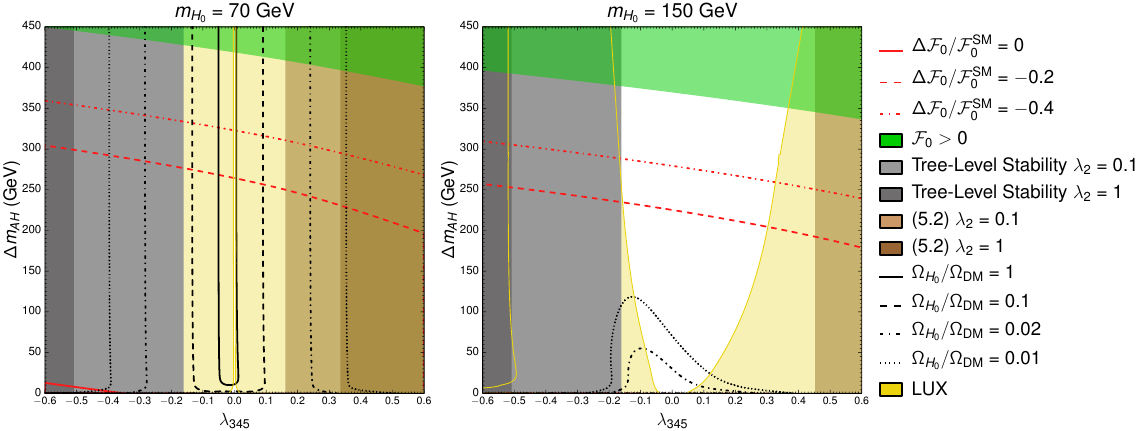
Figure 10 . (cid:21) 345 vs (cid:1) m AH assuming m SM values of (cid:1) = , with the green region corresponding to (cid:1) 0 F 0 F and brown regions are respectively excluded by boundedness from below of the scalar potential and by the failure to ful(cid:12)ll eq. (5.2), respectively for (cid:21) 2 = 1 (dark) and (cid:21) 2 = 0 : 1 (light). Contours of constant (cid:10) H = (cid:10) DM = 1 ; 0 : 1 ; 0 : 02 ; 0 : 01 are shown as solid, dashed, dash-dotted and dotted black 0 lines. The excluded region from LUX [78] is shown in pale